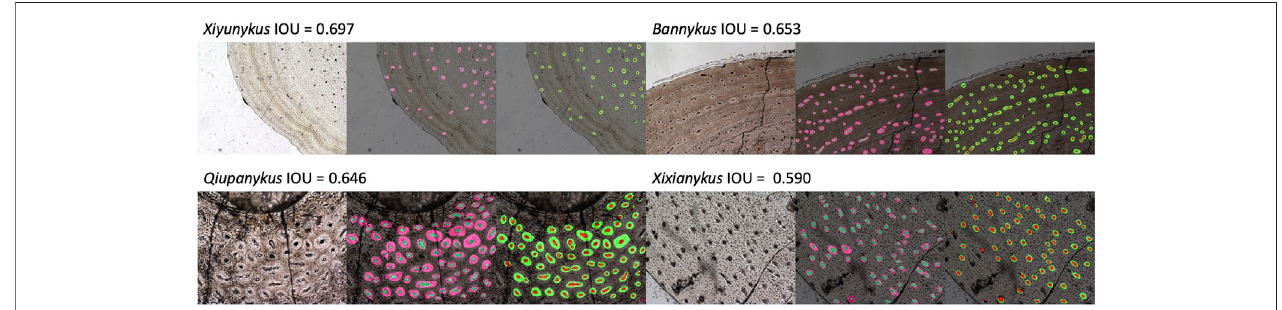
FIGURE3| Segmentationresultsofprimaryandosteons,fromlefttoright:originalimage,groundtruth,andprediction. Thesmallercircleineachlargercirclelabels the vascular canal.